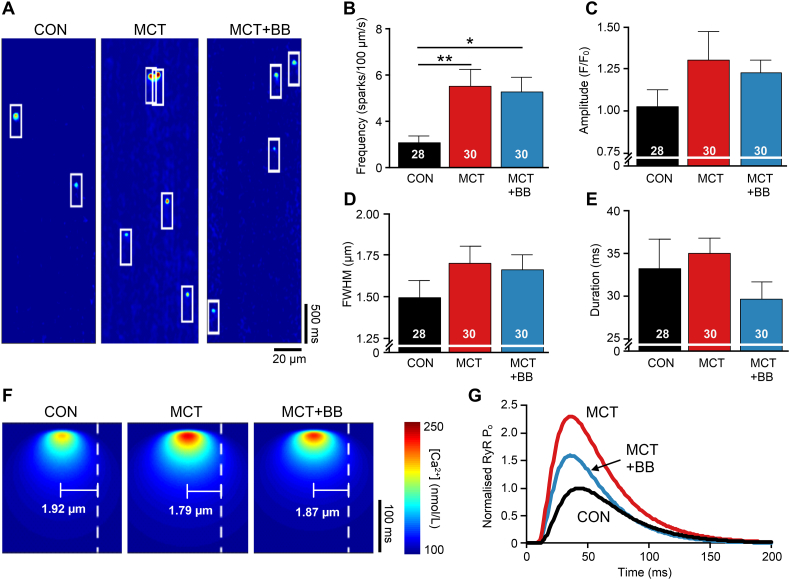
Increased frequency of Ca2+ sparks in PAH. A Exemplar confocal linescan recordings showing Ca2+ sparks (outlined by boxes). B Mean Ca2+ spark frequency was significantly increased in MCT cells and was not affected by BB treatment. Myocyte numbers given in the figure. There were no statistically significant difference between the mean C Ca2+ spark amplitude, D full width at half-maximum (FWHM) and E duration of the 3 groups. F To estimate the likelihood of a Ca2+ spark activating RyR clusters at a neighbouring junction (i.e. spontaneous Ca2+ wave initiation), model Ca2+ sparks were created using the mean properties of CON, MCT and MCT + BB Ca2+ sparks in (C-E). The cytosolic [Ca2+] at distances corresponding to the mean resting sarcomere length of each group (dashed line) was calculated. G The peak time-varying RyR open probability (RyR Po) in the neighbouring junction was greatest in MCT, but was reduced by BB treatment. Data in (G) is normalised to CON. N = 5–8 rats per group, one way ANOVA. *P < .05, **P < .01.